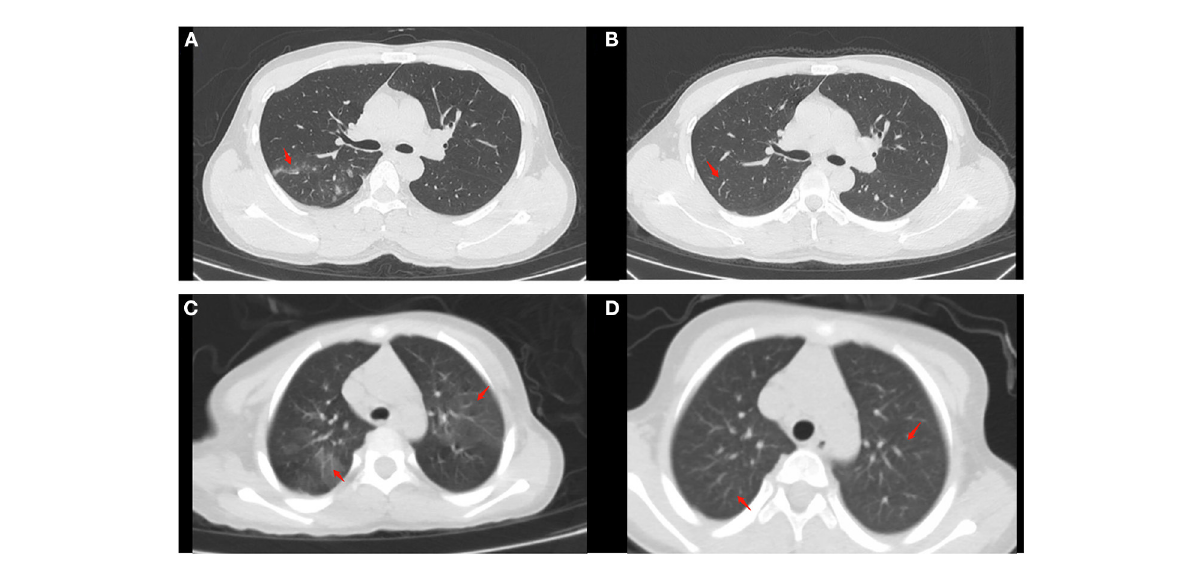
FIGURE4 Chest CT findings of moderate cases before and after treatment (as arrow points). (A) Patchy high-density shadow can be seen in the posterior segment of the upper lobe of the right lung before treatment in naïve patients. (B) The high-density shadow subsided after treatment in naïve patients. (C) Patchy high-density shadow and blurred edges can be seen in the upper lobes of both lungs in a refractory patient. (D) No significant abnormalities can be seen after treatment in the refractory